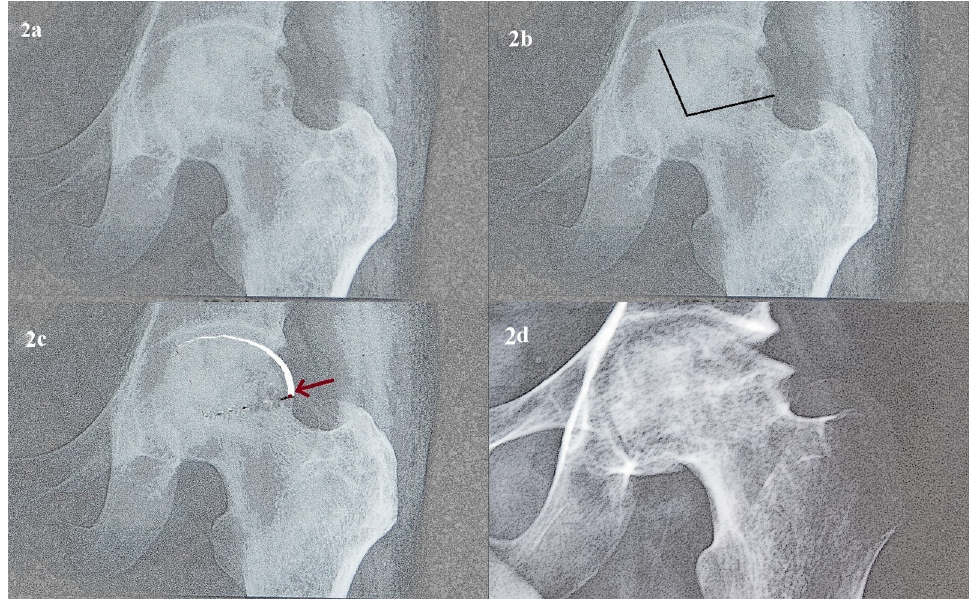
Figure 2. The mechanism of development of cam-type FAI in femoral heads after osteonecrosis: panel a: fragmentation in the femoral head with preservation of femoral head sphericity; panel b: it can be noticed from the radiograph that a large part of the femoral head is involved in the disease process; panel c: illustration of collapse of the femoral head. The entire diseased fragment undergoes collapse due to weakening of deeper metaphyseal bone. Subchondral bone and metaphyseal bone immediately deep to it remain intact; panel d: with remodelling of the step formed at anterolateral part of femoral head, a cam deformity develops.